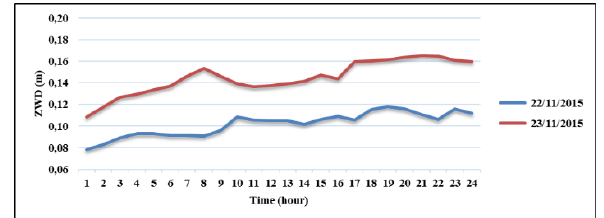
Figure 10. PM 10 time series of Zonguldak.